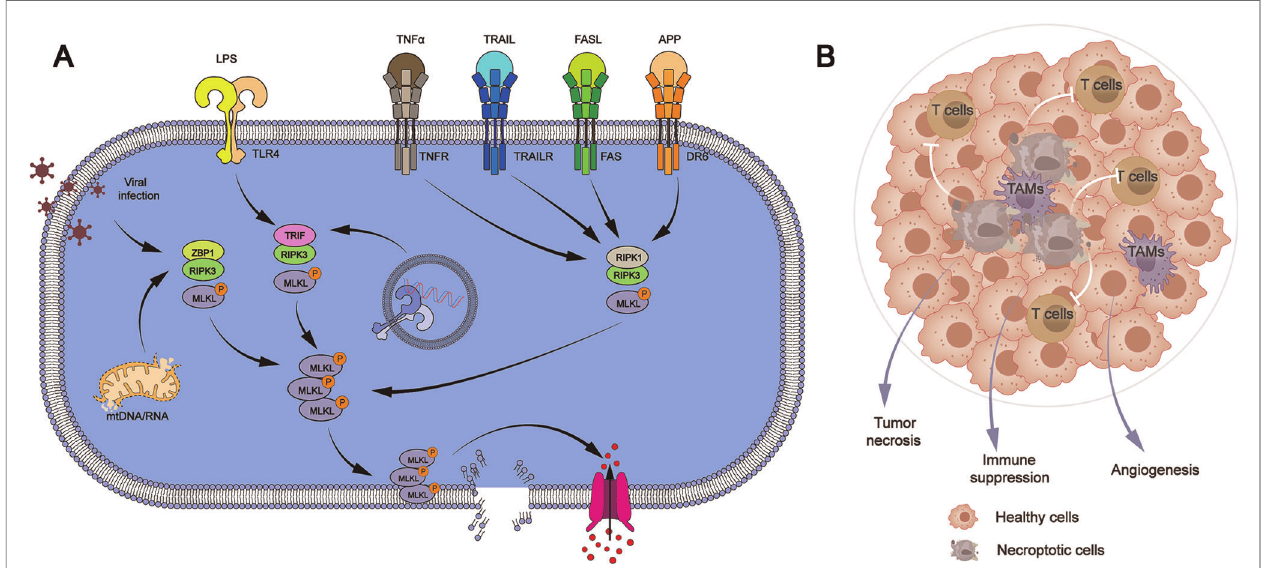
FIGURE 1 | Necroptosis pathway ( A ) and its role in cancer immunity ( B